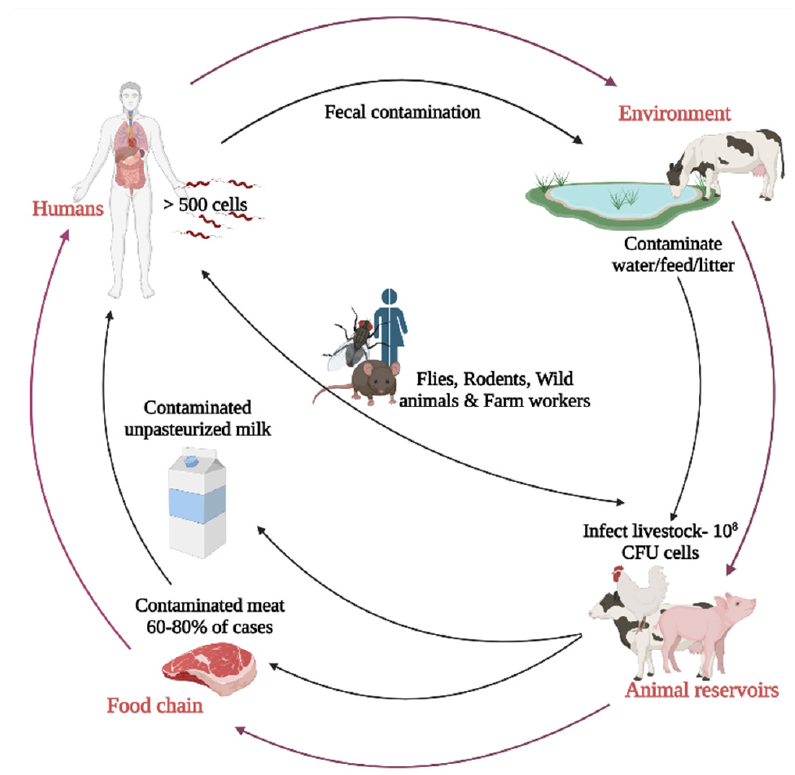
Figure 1. Reservoirs and routes of transmission of C. jejuni . Created with Biorender.com (accessed on 20 October